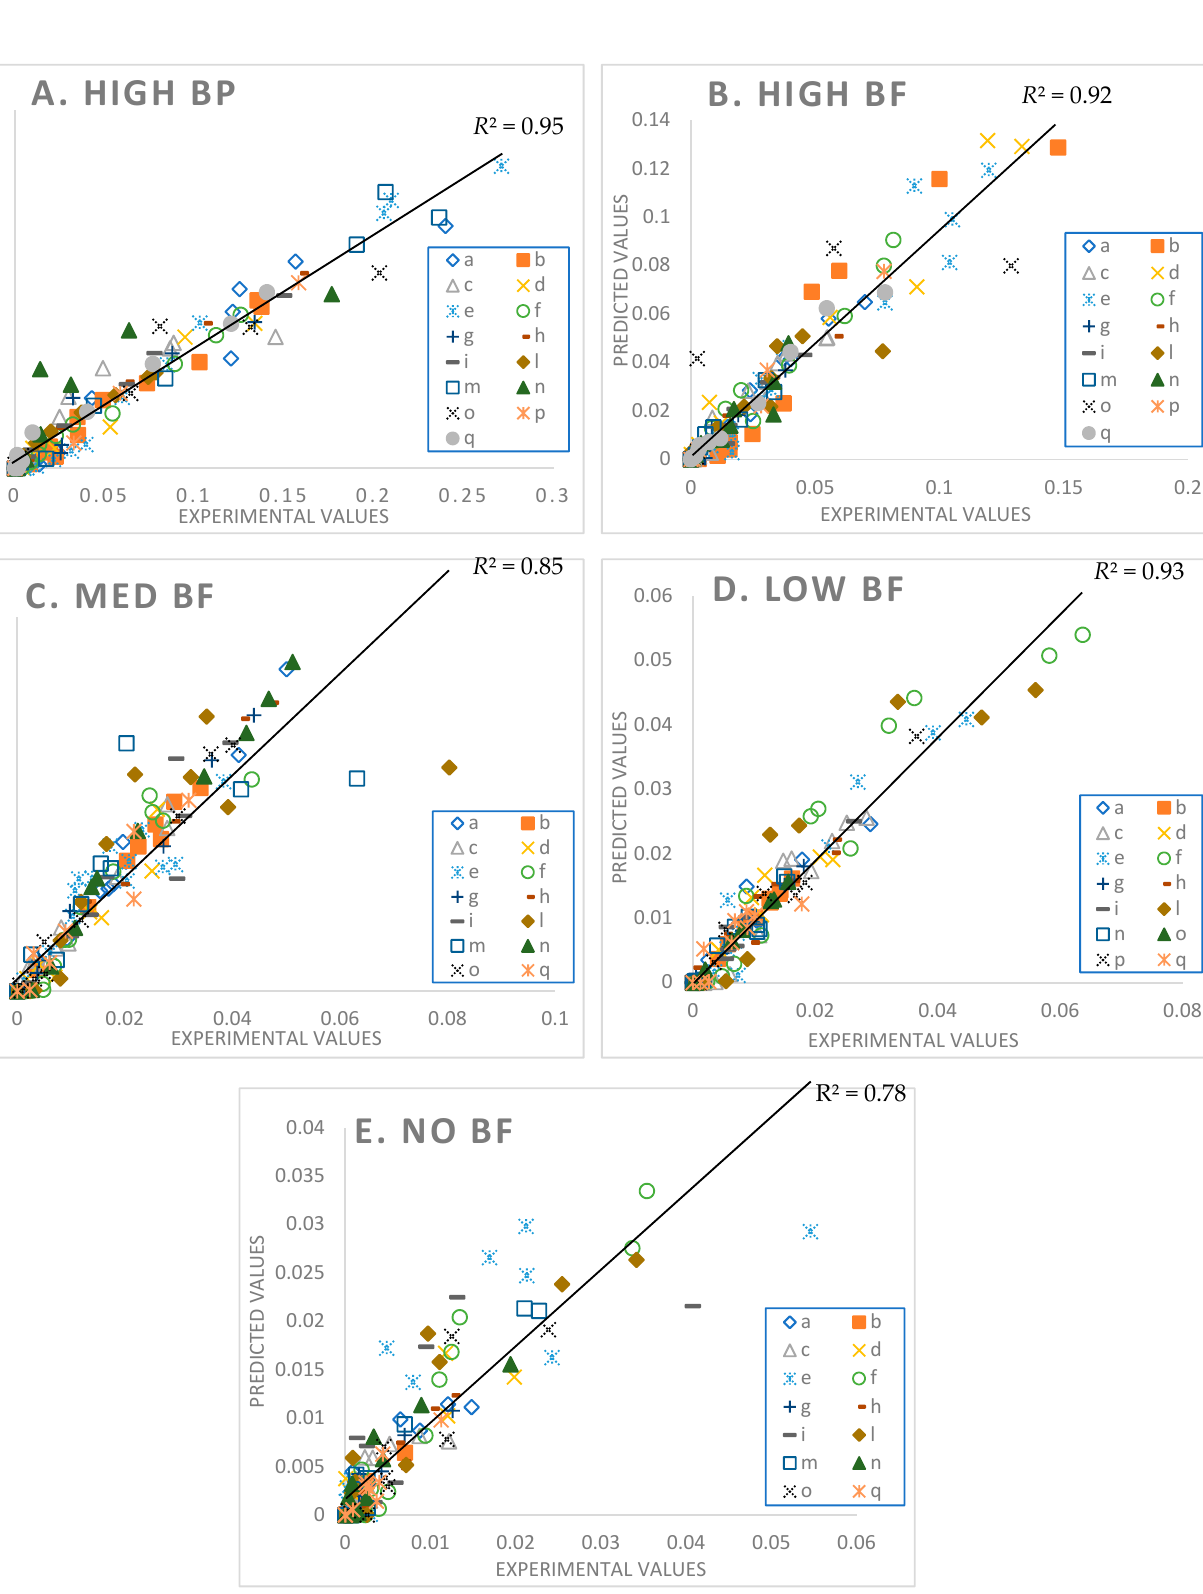
Figure 5. Parity plot of High MYR Broccoli Powder ( A ), High MYR Broccoli Florets ( B ), Medium MYR Broccoli Florets ( C ), Low MYR Broccoli Florets ( D ), and No MYR Broccoli Florets ( E ) with lumped participant data. Participants are designated by letters.